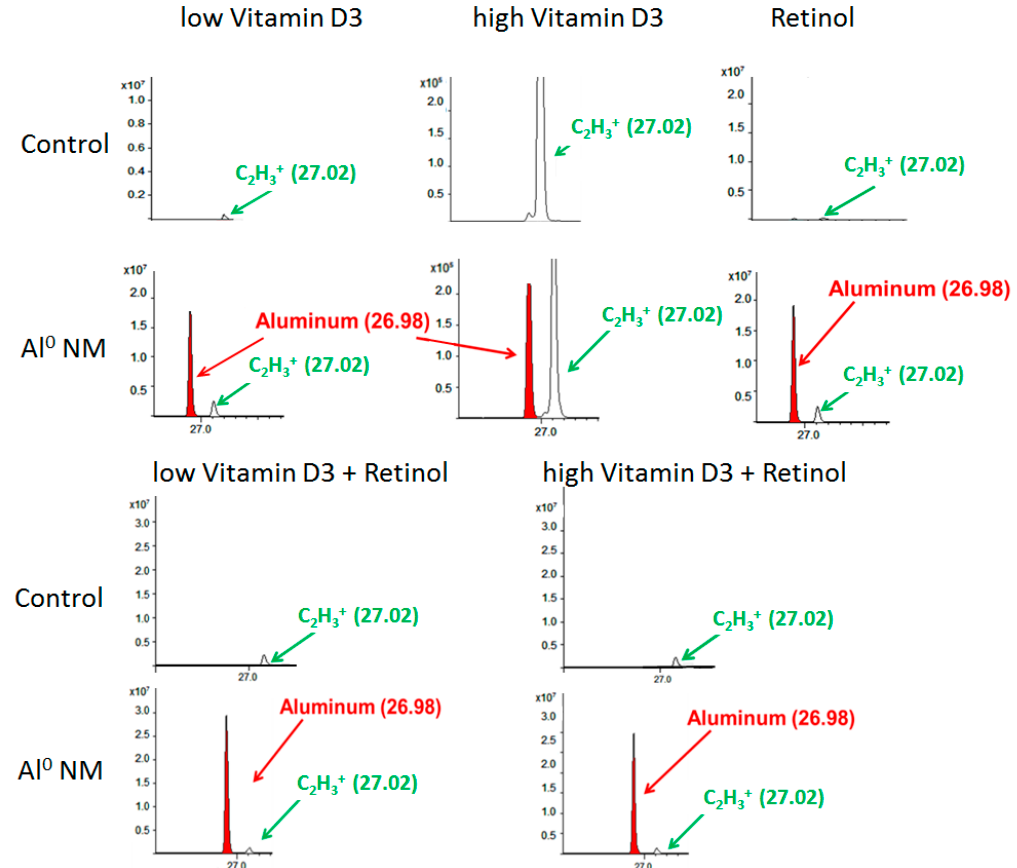
Figure 3. Time-of-flight secondary ion mass spectrometry (ToF-SIMS) mass spectrum (positive mode), showing the Al peak in red color (at m / e 26.98 u) and a peak in green color (at 27.02 u = C 2 H 3 + ), resulting from organic matter in HaCaT cells. The upper line shows the spectra for control HaCaT cells, the lower line for HaCaT cells which were exposed to Al NMs (about 20 nm) for 24 h in addition to high or low vitamin D3, and retinol or their combinations. The x-axis shows the mass to charge ratio ( m / z ); y-axis the ion intensities.